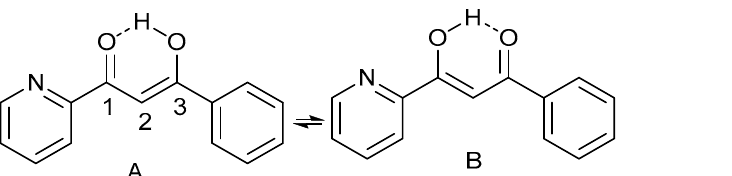
Figure 15. Tautomeric equilibrium illustrated by a β -diketone. The mole fraction of the B tautomer is x.